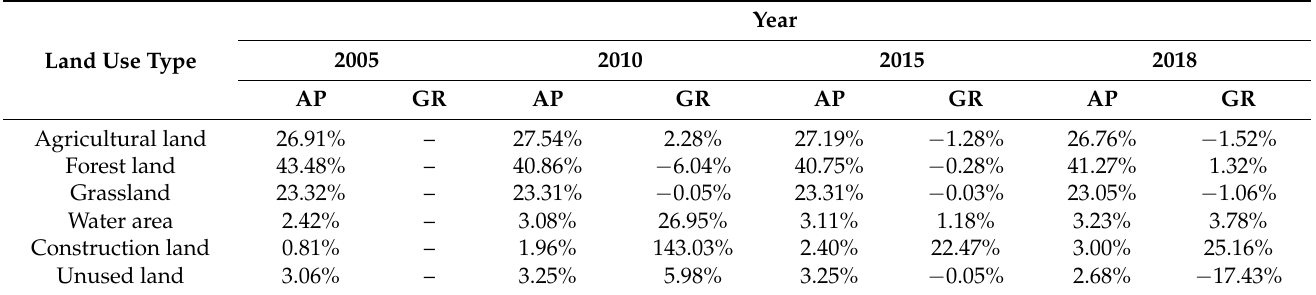
Table 3. Change in land use area proportion in different years in the Yangtze River basin. AP indicates the area proportion, and GR indicates the growth rate of the land use type from the previous year.